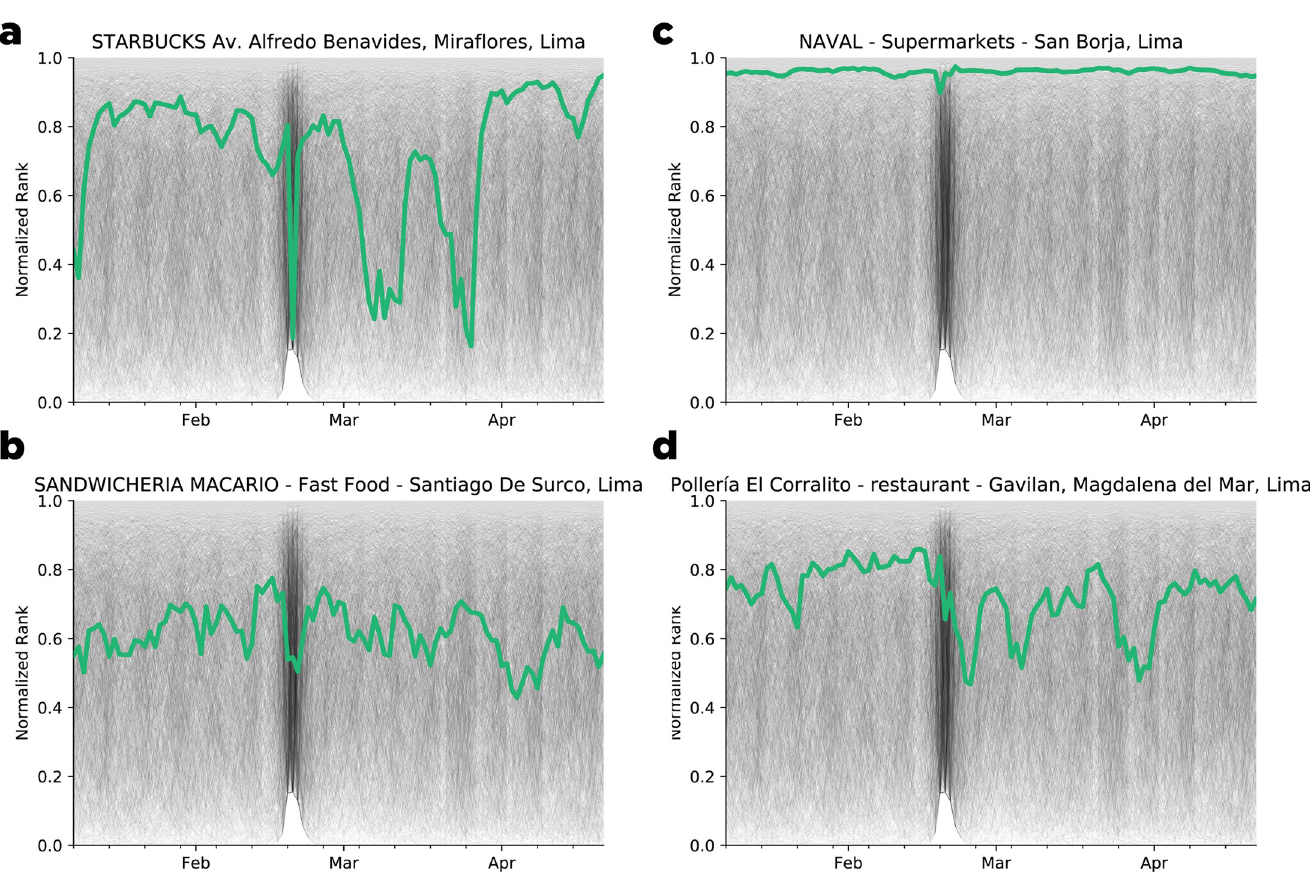
Fig 7. Example of the normalized rank evolution of merchants in Lima, Peru, during the interval of January 2017 to April 2017. a) Starbucks coffee shop. b) Fast food restaurant. c) Supermarket. d) Restaurant.